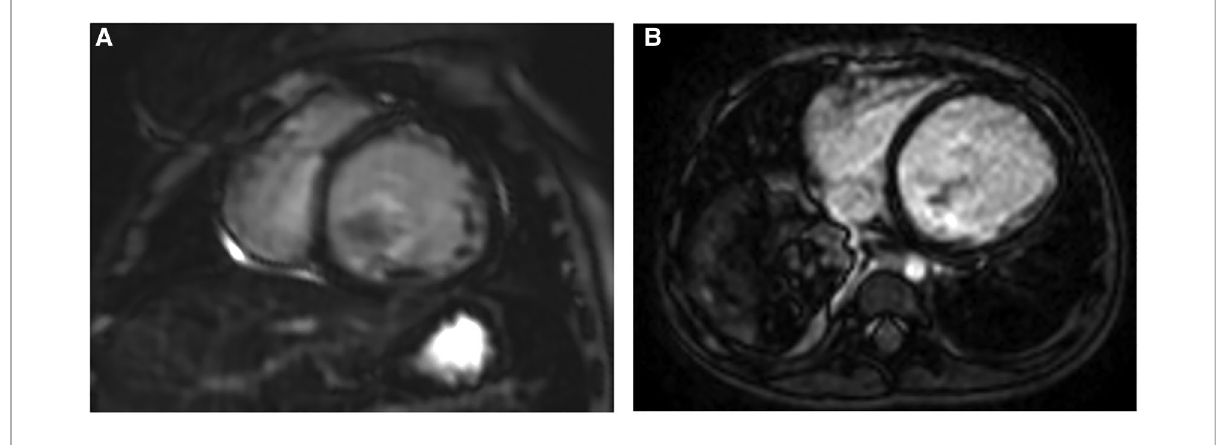
FIGURE 3 Representative images of MDE in two different EFE patients. ( A,B ) Short-axis and axial views showing no obvious delayed enhancement in both. EFE, endocardial fi